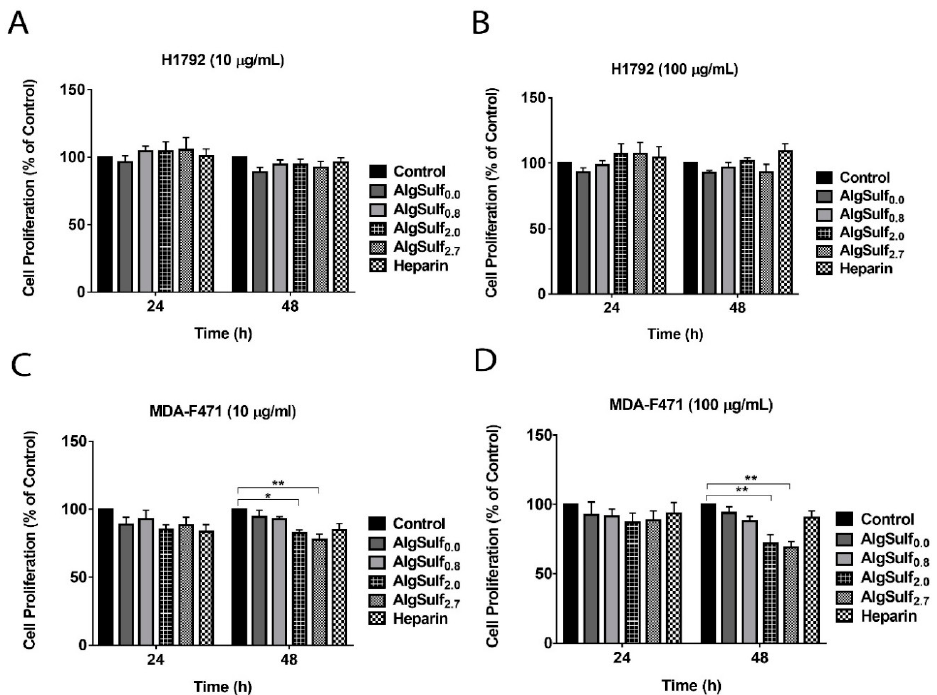
Figure 1. The effect of the DS of biomimetic sulfated GAGs on the activity of human (H1792) and murine (MDA-F471) LUAD cell lines. The metabolic activity of ( A ) H1792 treated with 10 µg/mL of AlgSulf n ( B ) H1792 treated with 100 µg/mL of AlgSulf n ( C ) MDA-F471 treated with 10 µg/mL of AlgSulf n and ( D ) MDA-F471 treated with 100 µg/mL of AlgSulf n . For each graph, heparin was added at the same concentration of the polysaccharides as positive controls, and untreated cells (media only) were used as a negative control. Results are expressed as the percentage of the treated group compared to control after 24 h and 48 h of culture. Data represent the average of five independent experiments and are reported as mean ± SEM (* p < 0.05; ** p < 0.01) using two-way ANOVA followed by Bonferroni’s multiple comparison